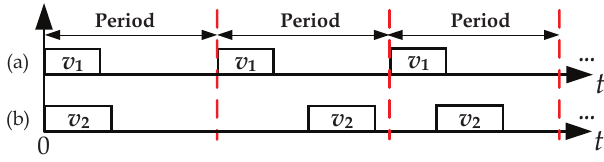
Figure 2. Strictly and non-strictly periodic